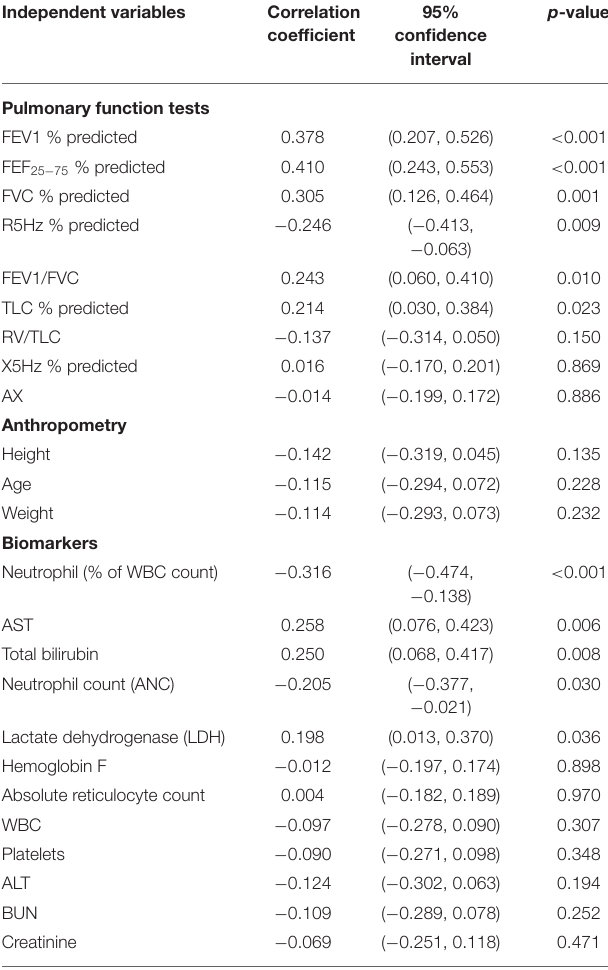
TABLE 2 | Correlations between DLCO and clinical